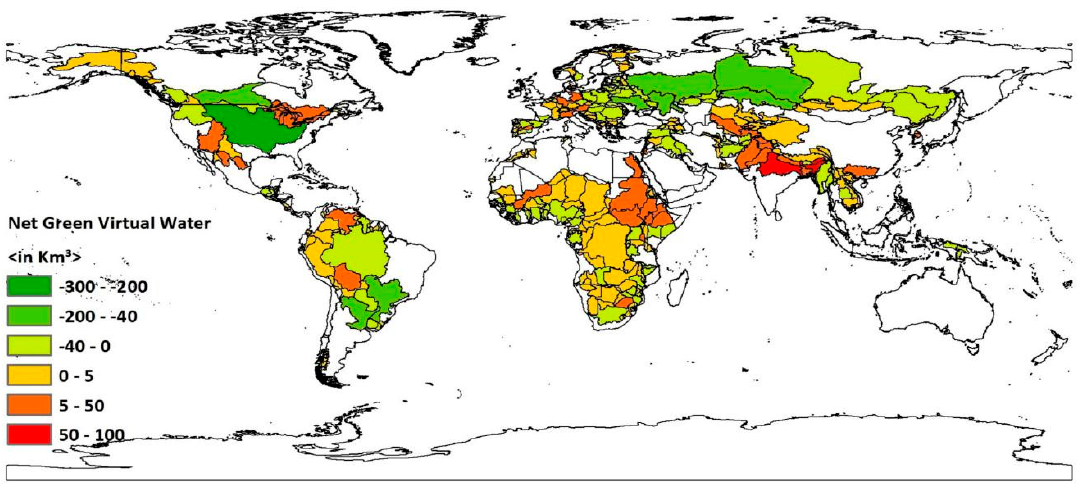
Figure 4. Net green virtual water balance for global transboundary river basins’ country-basin units. Period: 1996–2005. This map was generated with ArcGIS 10.2 for desktop from Environmental Systems Research Institute (ESRI), Redlands, CA, USA [28].